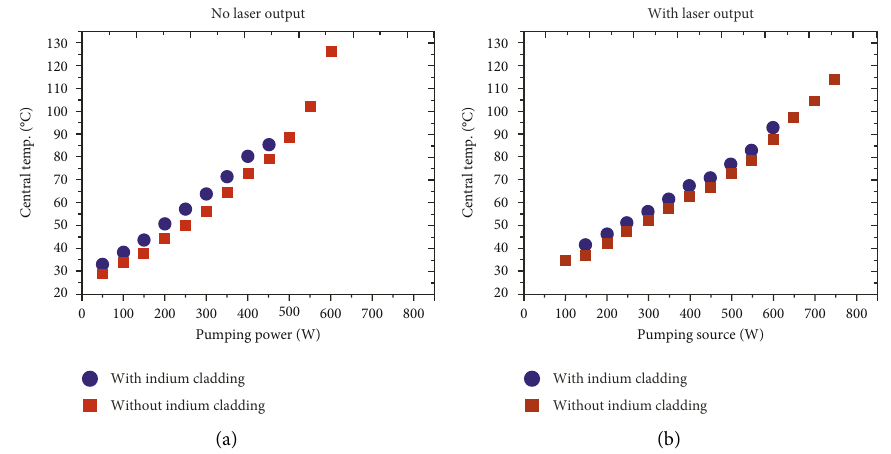
Figure 10: The center temperature with and without indium cladding. (a) Without laser. (b) With laser.